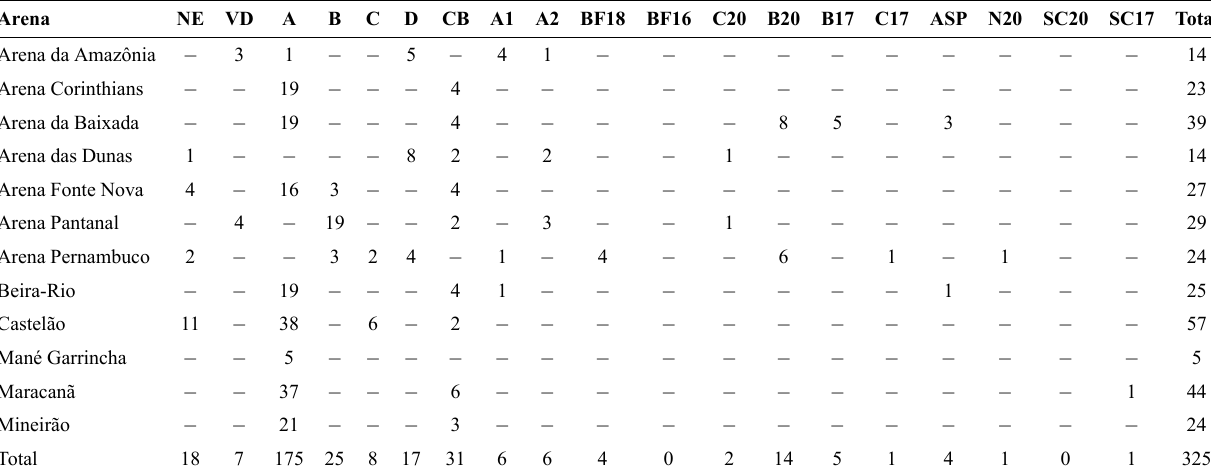
Table 7 - Arena usage in the 2019 season. Arena NE VD